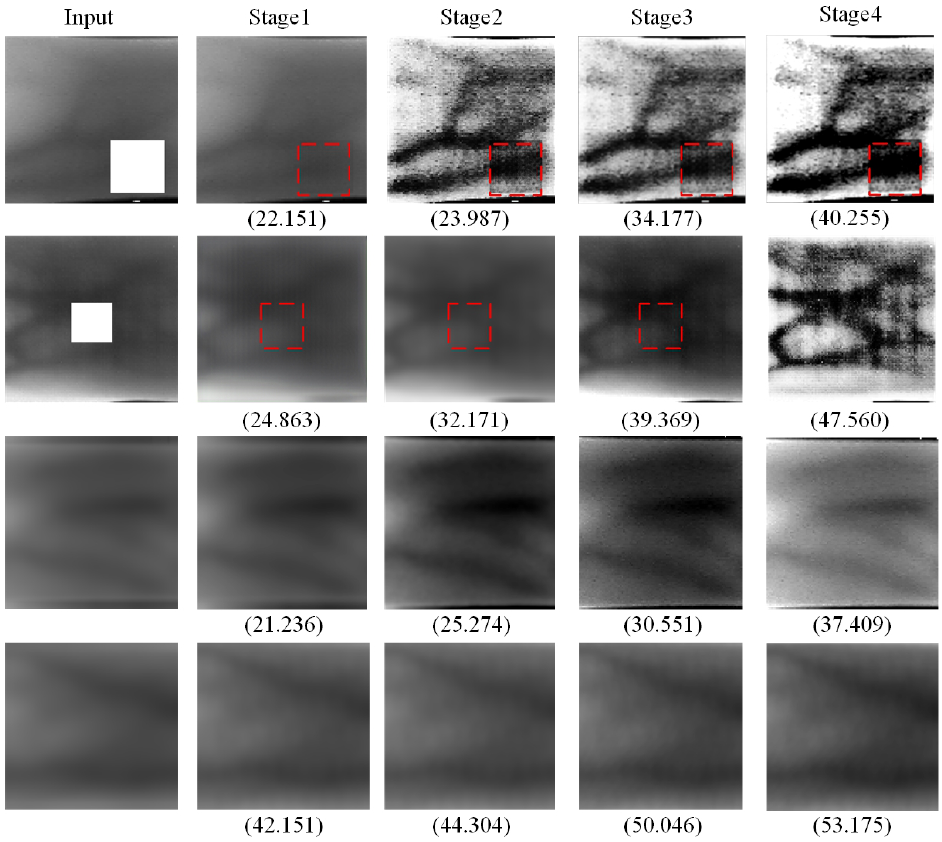
Figure 13. Output images and their PSNR values for each stage of the 4-stage DRL-FVRestore restoration